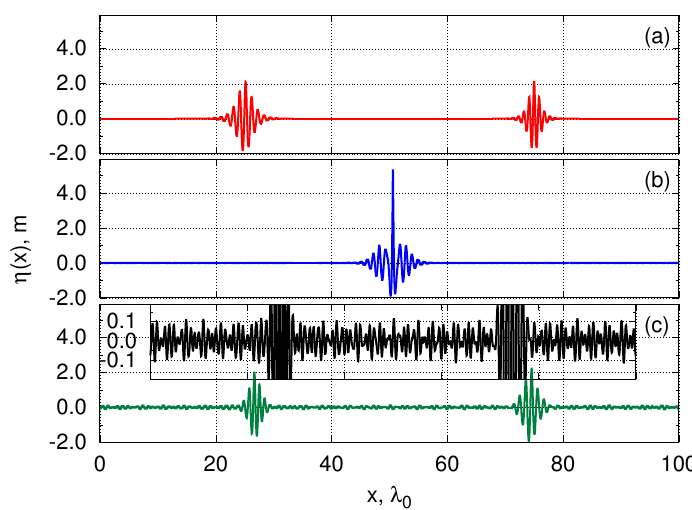
Figure 6. Collision of breathers studied in experiment 3 with the relative velocity ∆ V = 8% and the phase difference ∆ φ ≈ 0.7. Snapshots show the surface elevation function η ( x ) at the initial moment of simulation (snapshot ( a )); at the moment of maximum amplitude amplification (snapshot ( b )) and at the final moment of simulation (snapshot ( c )). Zoom of the final amplitude profile is shown in the inset of the snapshot ( c ).